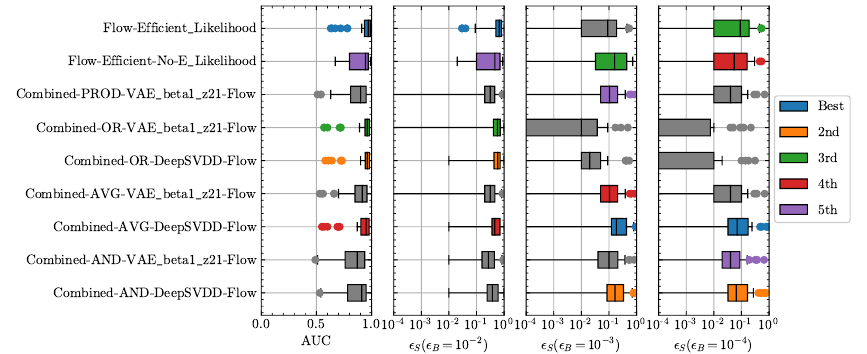
Figure 15: Box plots summarizing the anomaly detection techniques applied to all of the new physics signals. The colors denote the techniques that have the highest mean scores for each of the figures of merit.